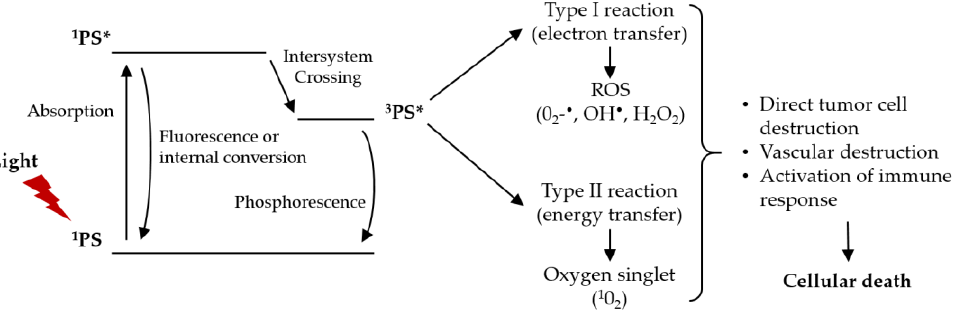
Figure 1. Modified Jablonski diagram of the PDT action mechanism. Adapted from [7].